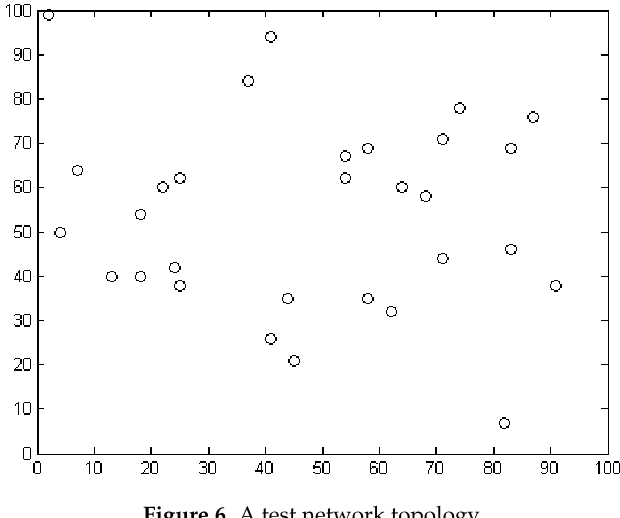
Figure 7. Comparison of the convergence of ACO and ACO&CM.